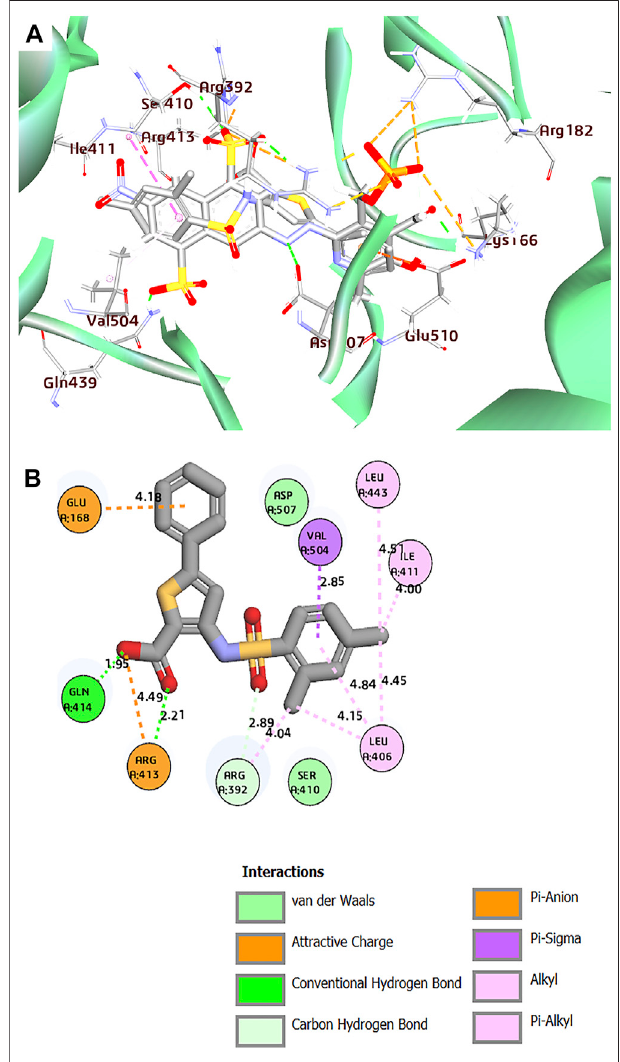
FIGURE 4 | (A) Superposition of co-crystal structures of PPNDS and CHEMBL167790 along with their interactions in the binding site of HuNoV RdRp (PDB: 4LQ3). (B) 2D representation of the protein – ligand complex of CHEMBL167790 including distances between the ligands and the interacting